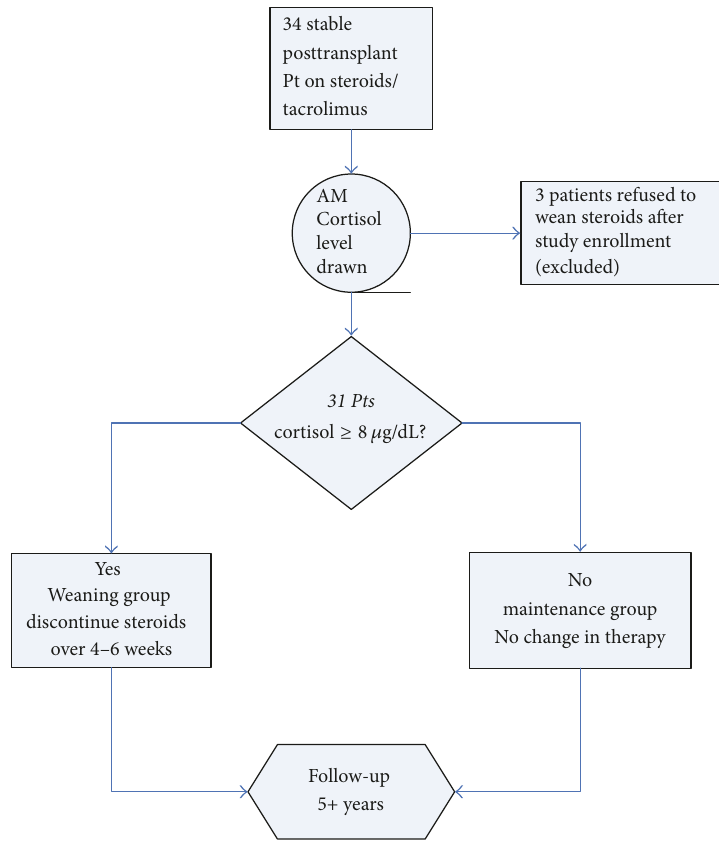
Figure 1: Study flow